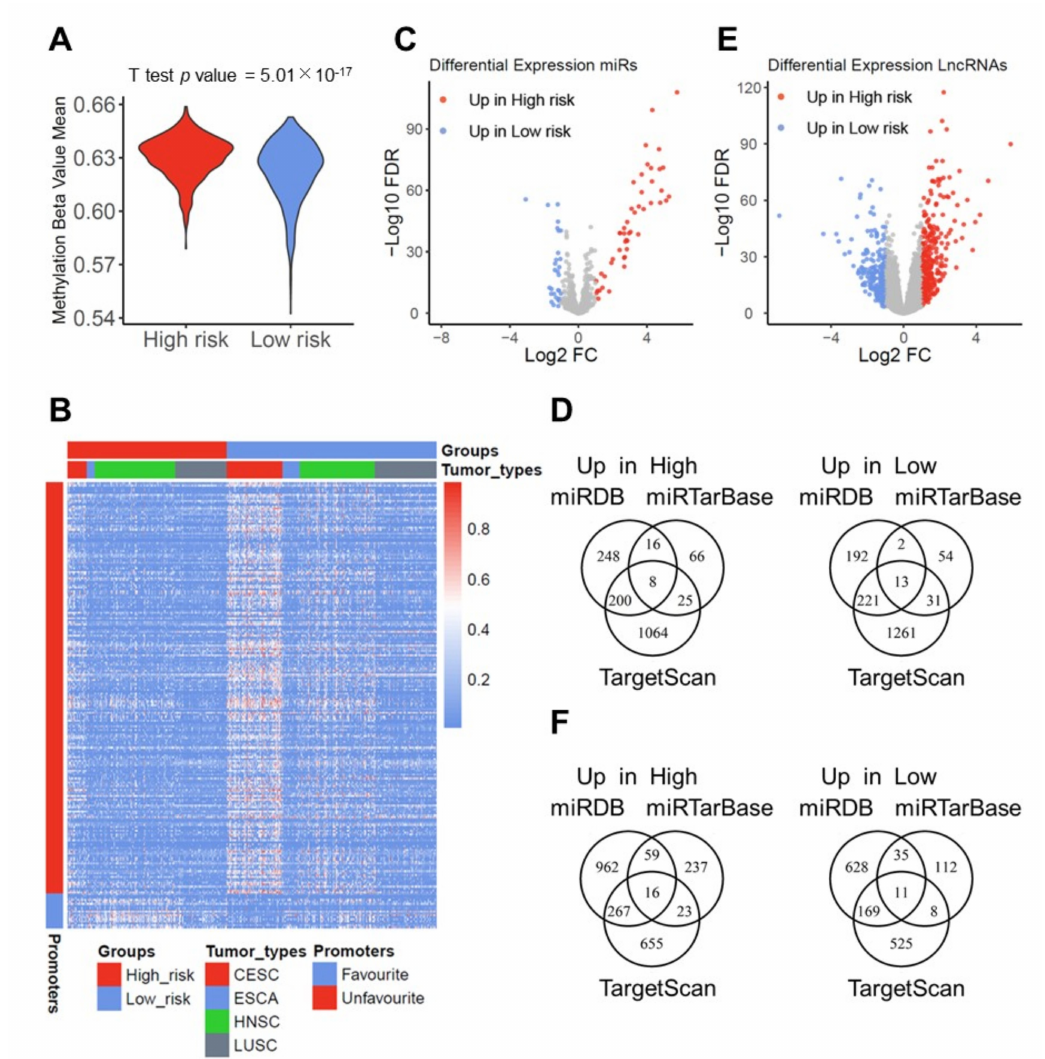
Figure 4. Differences in the epigenetic landscape among high-risk and low-risk subgroups of the pan-SCC cohort. ( A ) Violin plot demonstrates significant higher genome-wide beta mean values for promoter DNA methylation of the low-risk as compared to the high-risk groups in the pan-SCC cohort. ( B ) Heatmap shows beta values for differentially methylated probes ( n = 231) annotated for promoters of DEGs among high-risk and low-risk subgroups of the pan-SCC cohort. ( C ) Volcano plot shows significant differentially expressed miRs (DEFMs, n = 78) among high-risk and low-risk groups of the pan-SCC cohort ( − 1 > log 2 FC > 1, FDR < 0.05). ( D ) Venn diagrams summarize the amount of predicted DEFM-DEG links according to indicated databases and miRs which are up-regulated in either high-risk (left) or low-risk (right) groups of the pan-SCC cohort. ( E ) Volcano plot shows significant differentially expressed lncRNAs ( n = 513) among high-risk and low-risk groups of the pan-SCC cohort ( − 1 > log 2 FC > 1, FDR < 0.05). ( F ) Venn diagrams summarize the amount of predicted miR-DEG links according to indicated databases and based on miRs, which are linked to differentially expressed lncRNAs, which are up-regulated in either the high-risk group (left) or the low-risk group of the pan-SCC